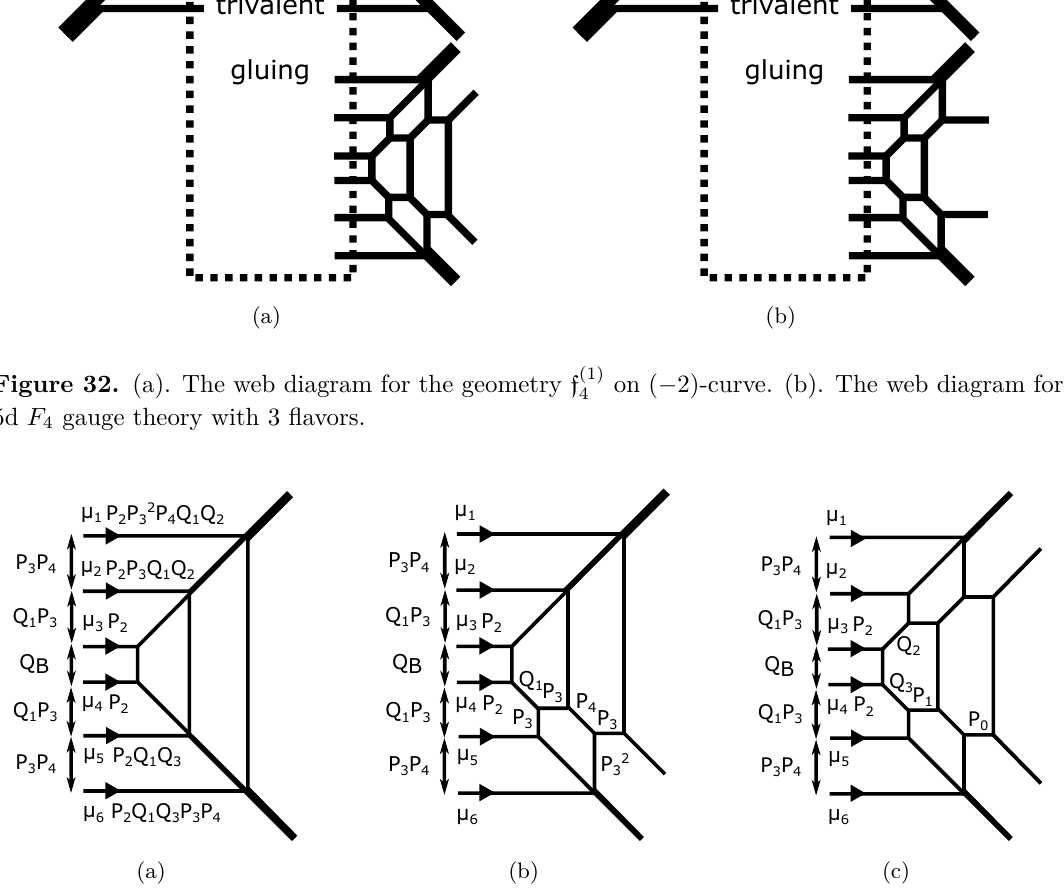
on ( − 2) -curve in figure 4